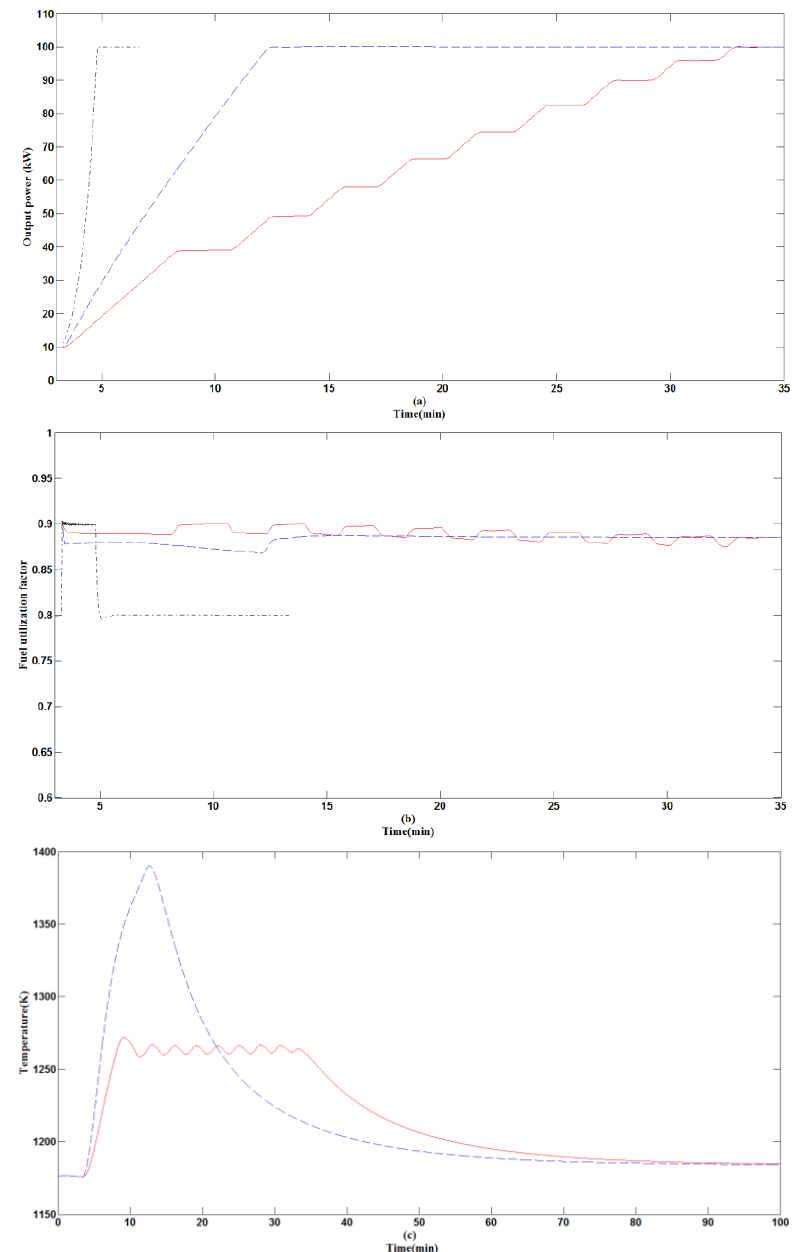
Figure 7. Comparison of SOFC load tracking performance under hierarchical control scheme with considering T bound (──), hierarchical control scheme without considering T bound (---) and on-line control scheme of [27]